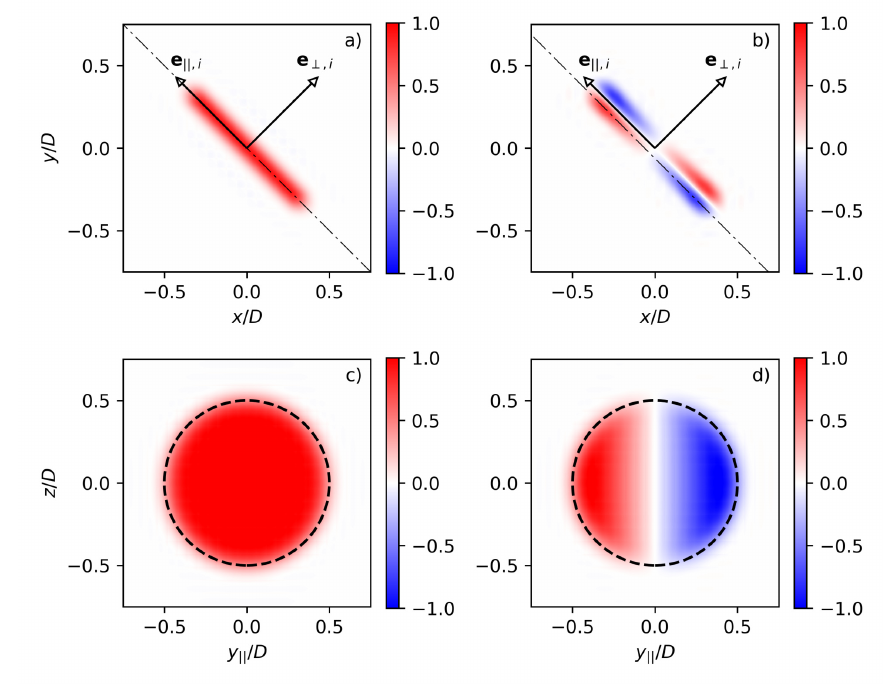
Figure A1. Geometrical filter kernels in Equation (A32). ( a , c ) Original stationary rotor footprint R . ( b , d ) New yaw-sensitivity footprint Q . ( a , b ) Planview at hub height. ( c , d ) Cross section through plane indicated by dot dashed line in ( a , b